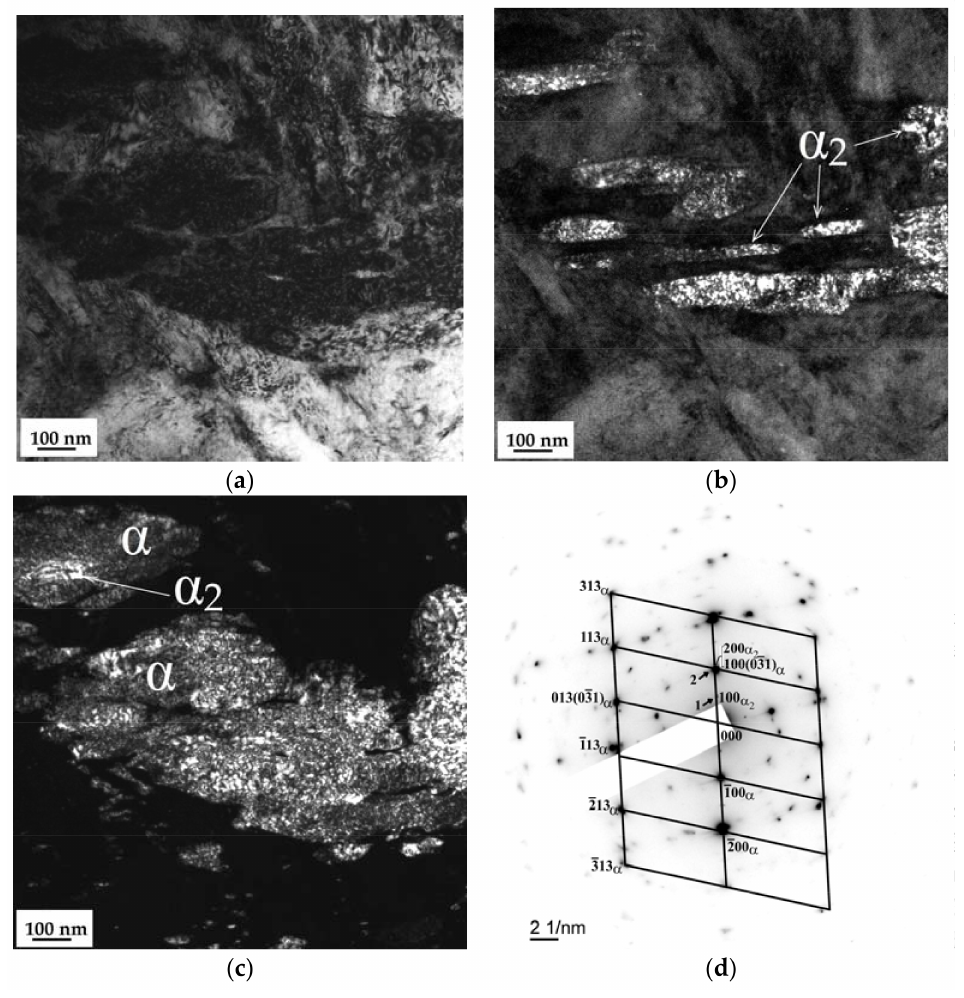
Figure 8. TEM bright- ( a ) and dark-field images ( b , c ) and associated SAED pattern ( d ) of the microstructure of EBM titanium Ti-6Al-4V parts after hydrogenation to 0.9 wt. %; b—the dark-field image obtained with 100 Ti3Al superstructure reflection (marked by an arrow 1); c—the dark-field image obtained with 200 Ti3Al and 100 α -Ti reflection (marked by an arrow